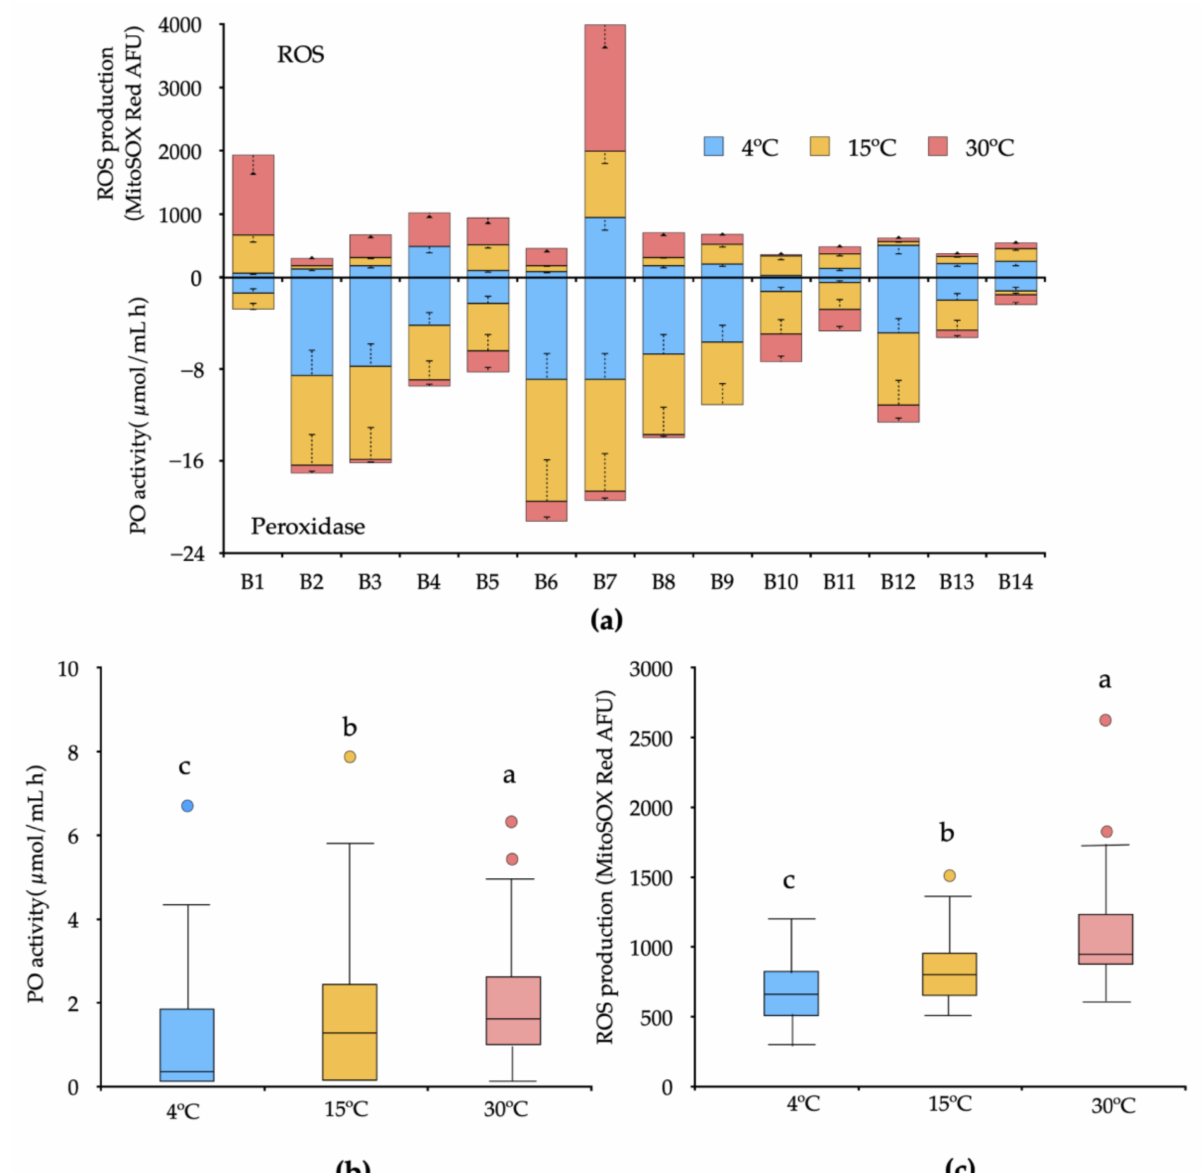
Figure 4. ( a ) Effect of temperature (4 ◦ C, 15 ◦ C, and 30 ◦ C) on peroxidase (PO) activity and ROS (O 2 − ) production (MitoSOX red fluorescence). Values were normalized with respect to the control (without Mn(II)). ( b , c ) Boxplots showing median, minimum, and maximum values; first and third quartile and outliers (colorful dots) of the PO activity and ROS production, respectivelly. Different letters show significant differences with p <